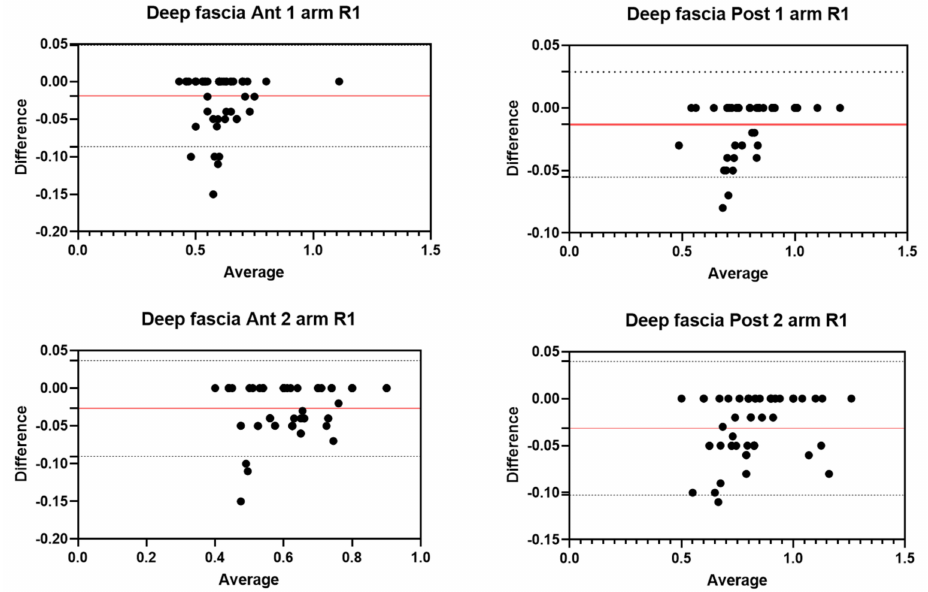
Figure 3. Bland–Altman plot comparing two sessions of Rater 1 (R1) measuring the US thickness of the deep fascia of the arm for the different levels. Red line = bias or mean difference; dashed lines: 95% limits of agreement (LoAs).